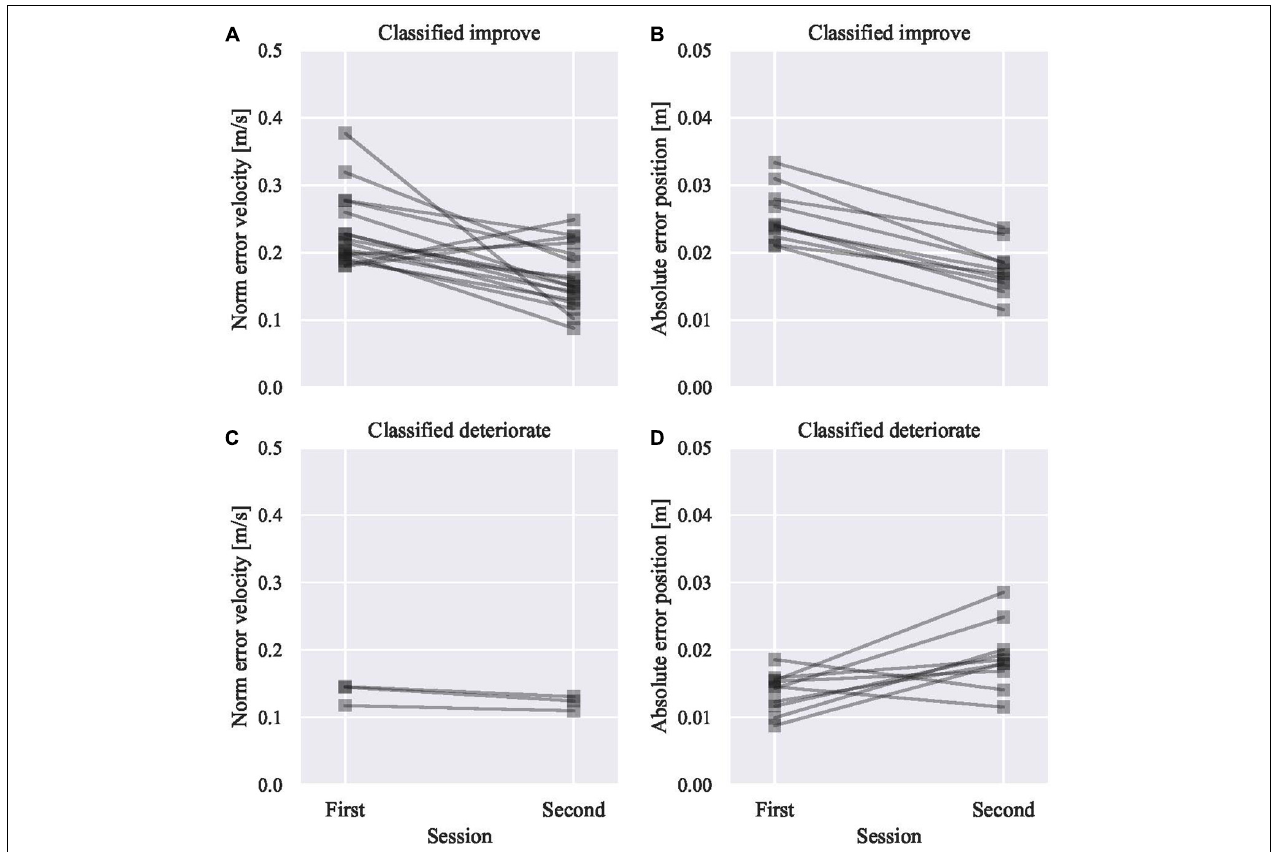
FIGURE 6 | (A) The classified subject for improving velocity error based on LOSO method. Subjects were above the boundary in the first session, so they are predicted to improve their performance in the second session. Most of them scored fewer errors in the second session. (B) Subject predicted as to improve positional error. (C) Subject predicted as to deteriorate velocity error. (D) Subject predicted as to deteriorate positional error. TABLE 4 | Classification in groups. Below position threshold Above position threshold Above velocity threshold Number of subjects = 7 (Color in Figure 7 : Blue) Number of subjects = 10 (Color in Figure 7 : Red) Below velocity threshold Number of subjects = 0 Number of subjects = 3 (Color in Figure 7 :